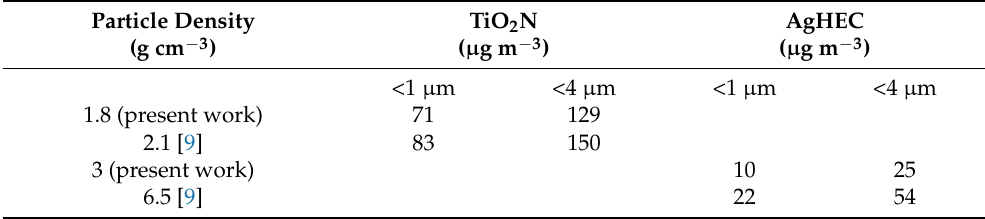
Table 6. TiO 2 N and AgHEC particle mass concentrations below 1 µ m and 4 µ m by taking into account the measured averaged volume size distribution during the field campaign and different particle density values: present work and Koivisto et al. (2022),